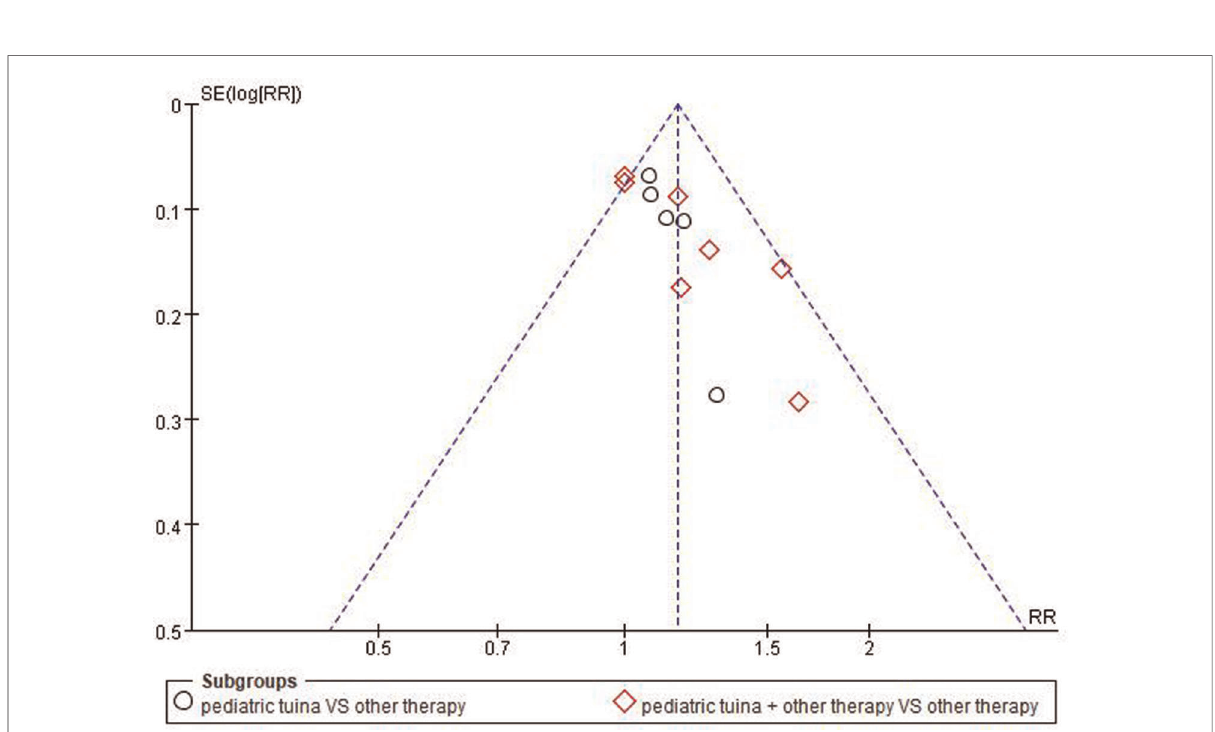
FIGURE 13 The funnel plot of publication